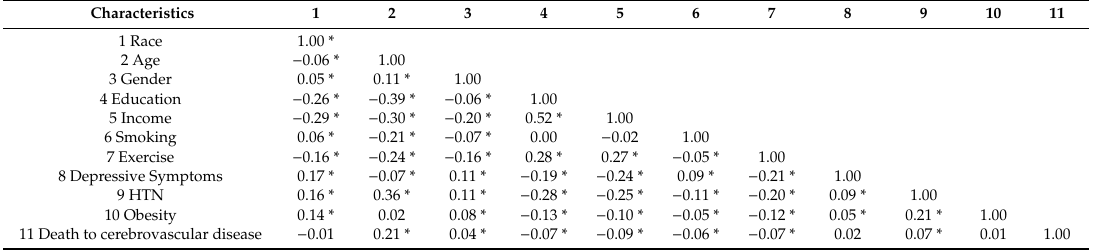
Table 2. Correlation matrix of the study variables ( n =